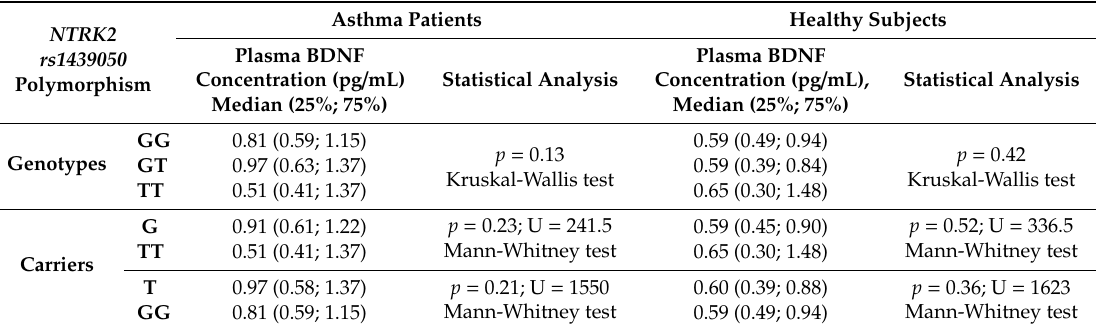
Table 5. Plasma BDNF concentration in asthma patients and healthy subjects carrying different NTRK2 rs1439050 genotypes and alleles.